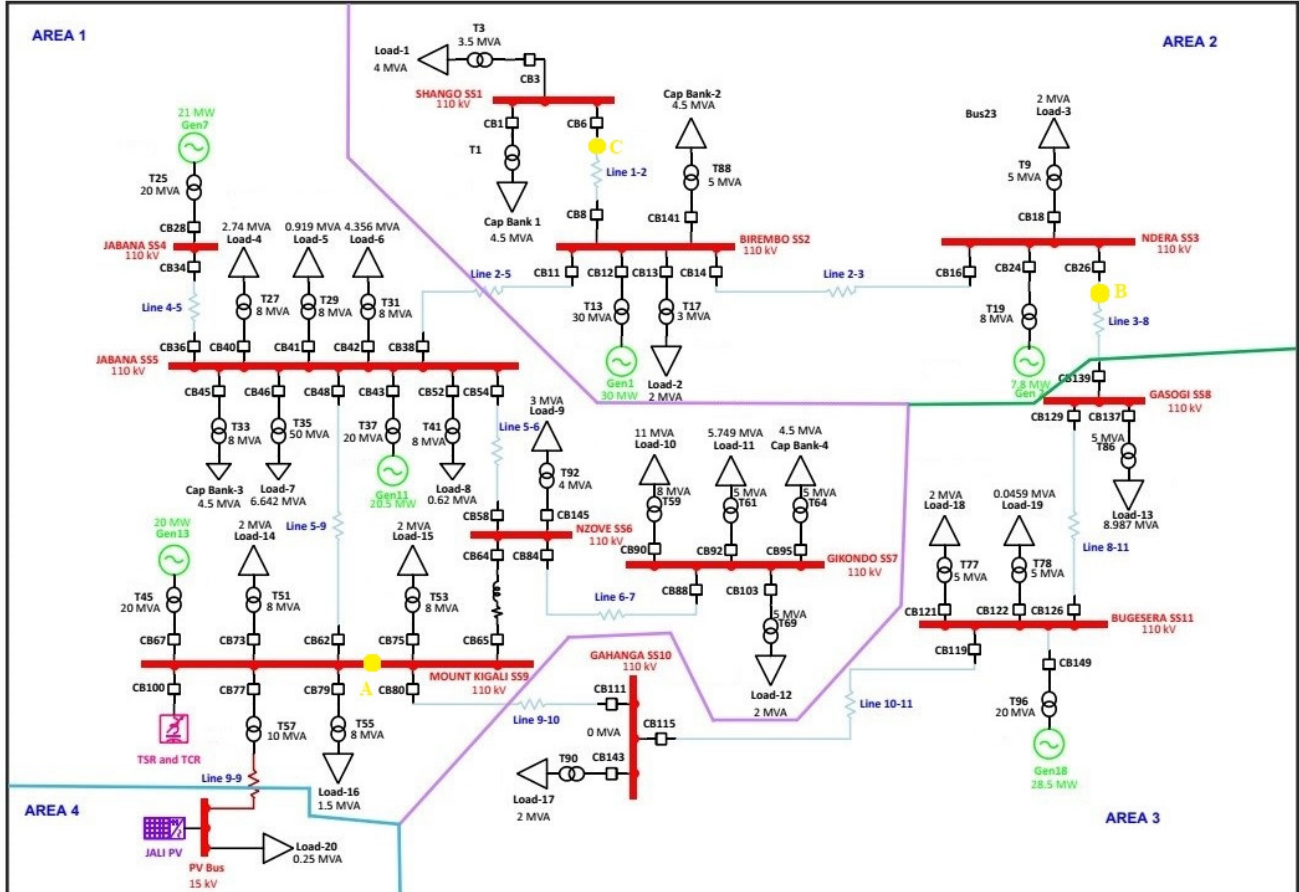
Figure 2. Kigali National Grid system with five coherence areas.